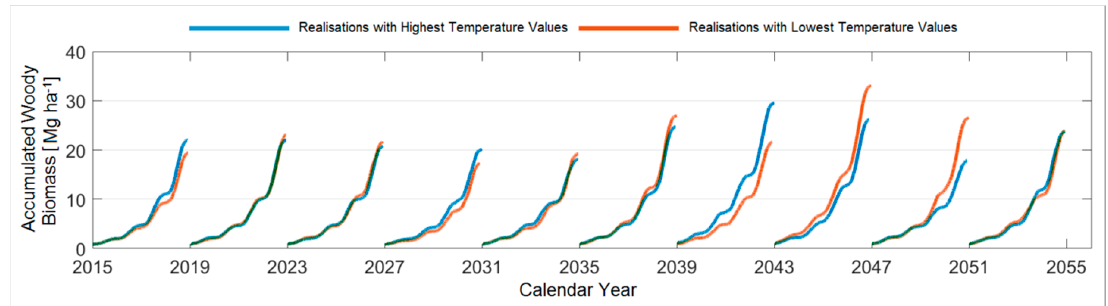
Figure A4. Projected woody biomass of poplar trees under special realisations describing either the highest temperature values (blue) or the lowest temperature values (orange) with respect to the ten established growing periods.